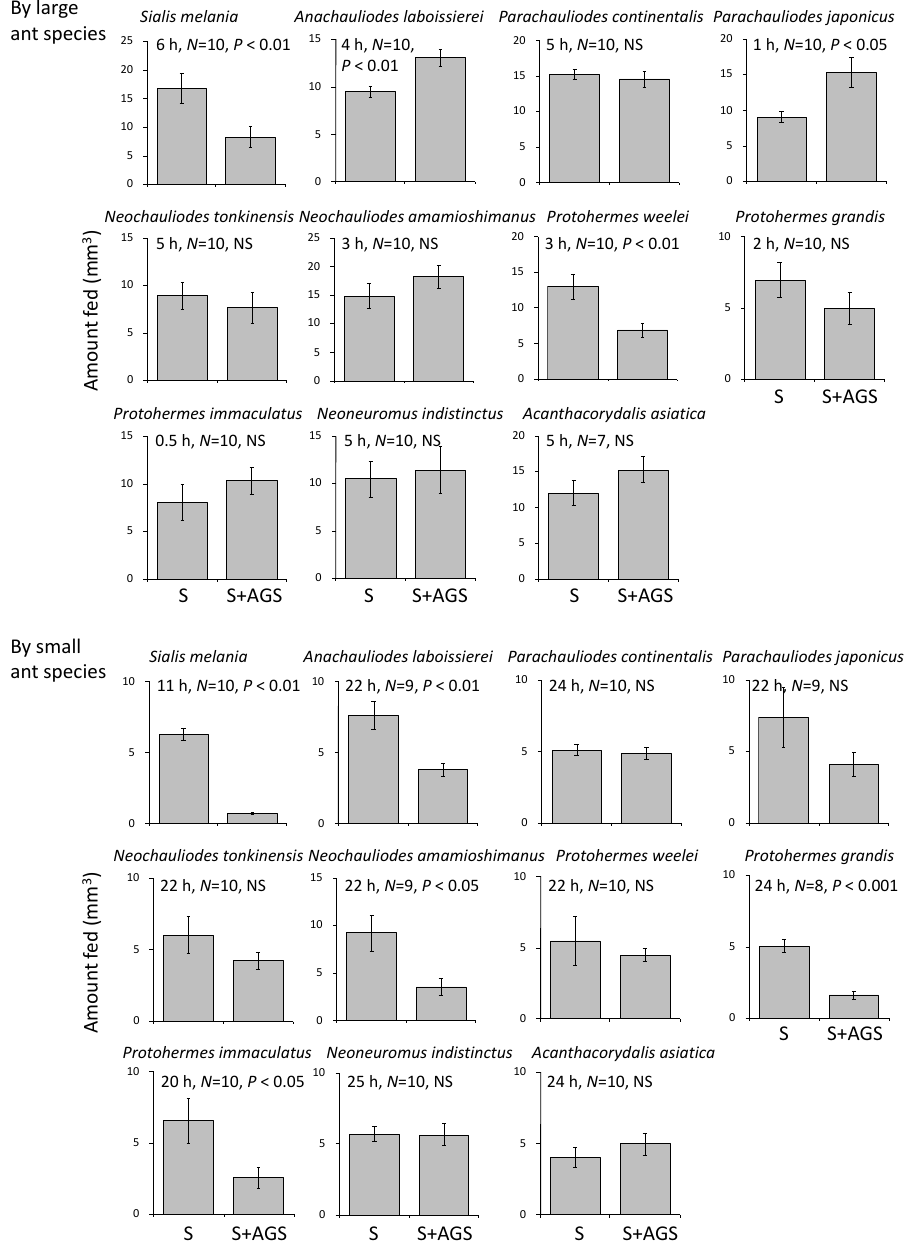
Figure 5. Effect of female accessory gland substances from several species of Megaloptera on avoidance of predation by the large ant species Camponotus japonicus (top) and the small ant species Formica japoninca (bottom). Two capillaries, one with sucrose solution only (S) and another with sucrose solution plus accessory gland substance (S + AGS), were offered simultaneously to each ant species for 1–25 h (see Figure 1c). N is the number of ants examined, and vertical bars show ± SE. The results of paired t -tests are also shown (NS: p >